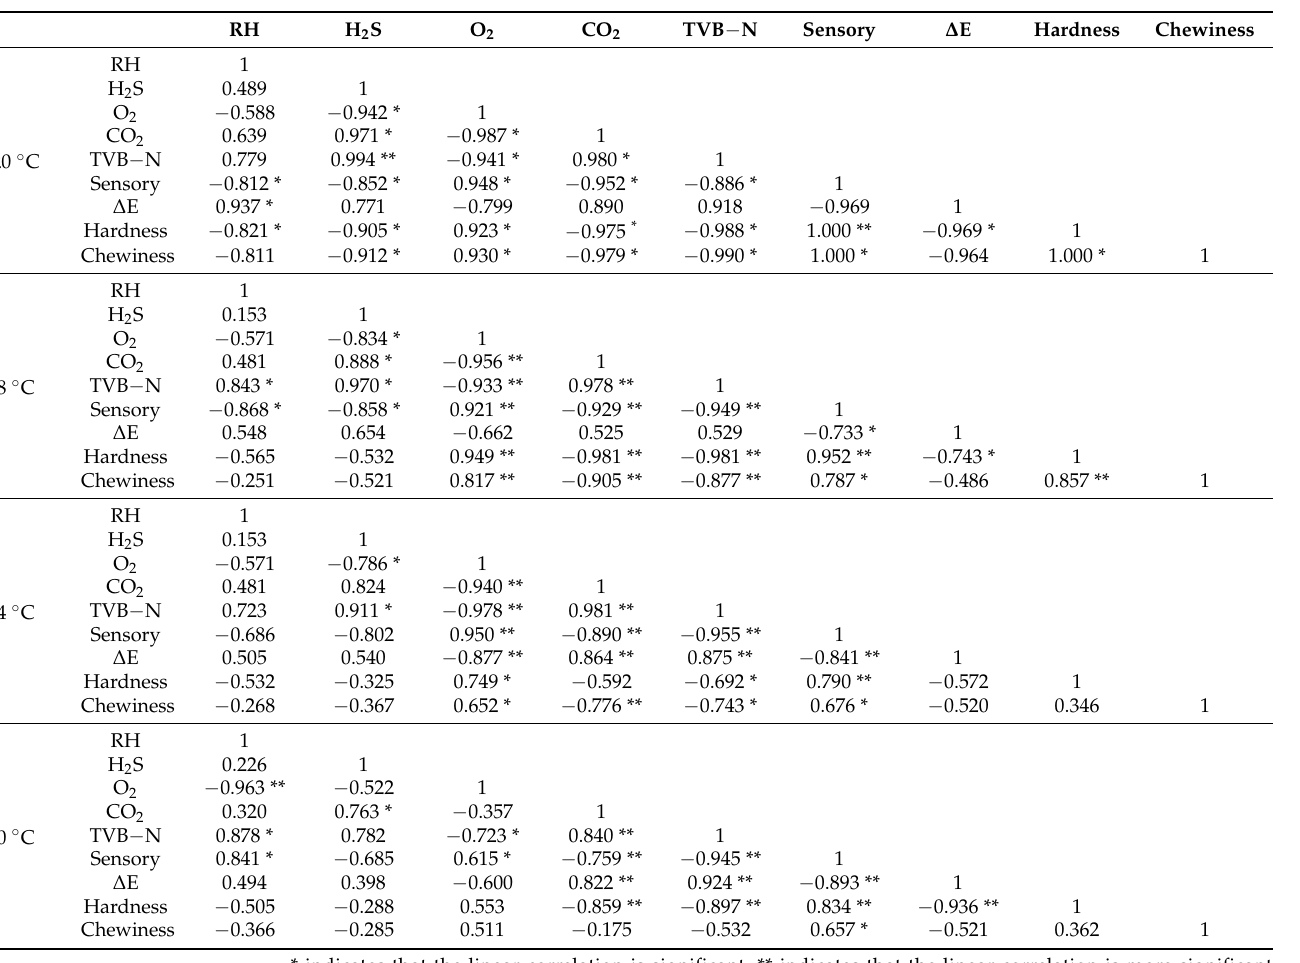
Table 3. Correlation matrix analysis of different